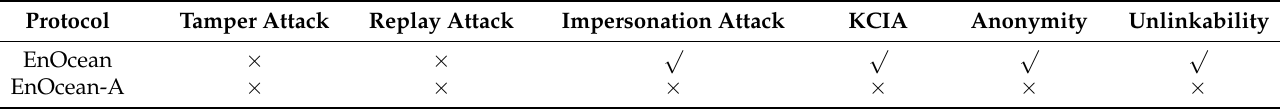
Table 8. Security comparison between EnOcean protocol and EnOcean-A